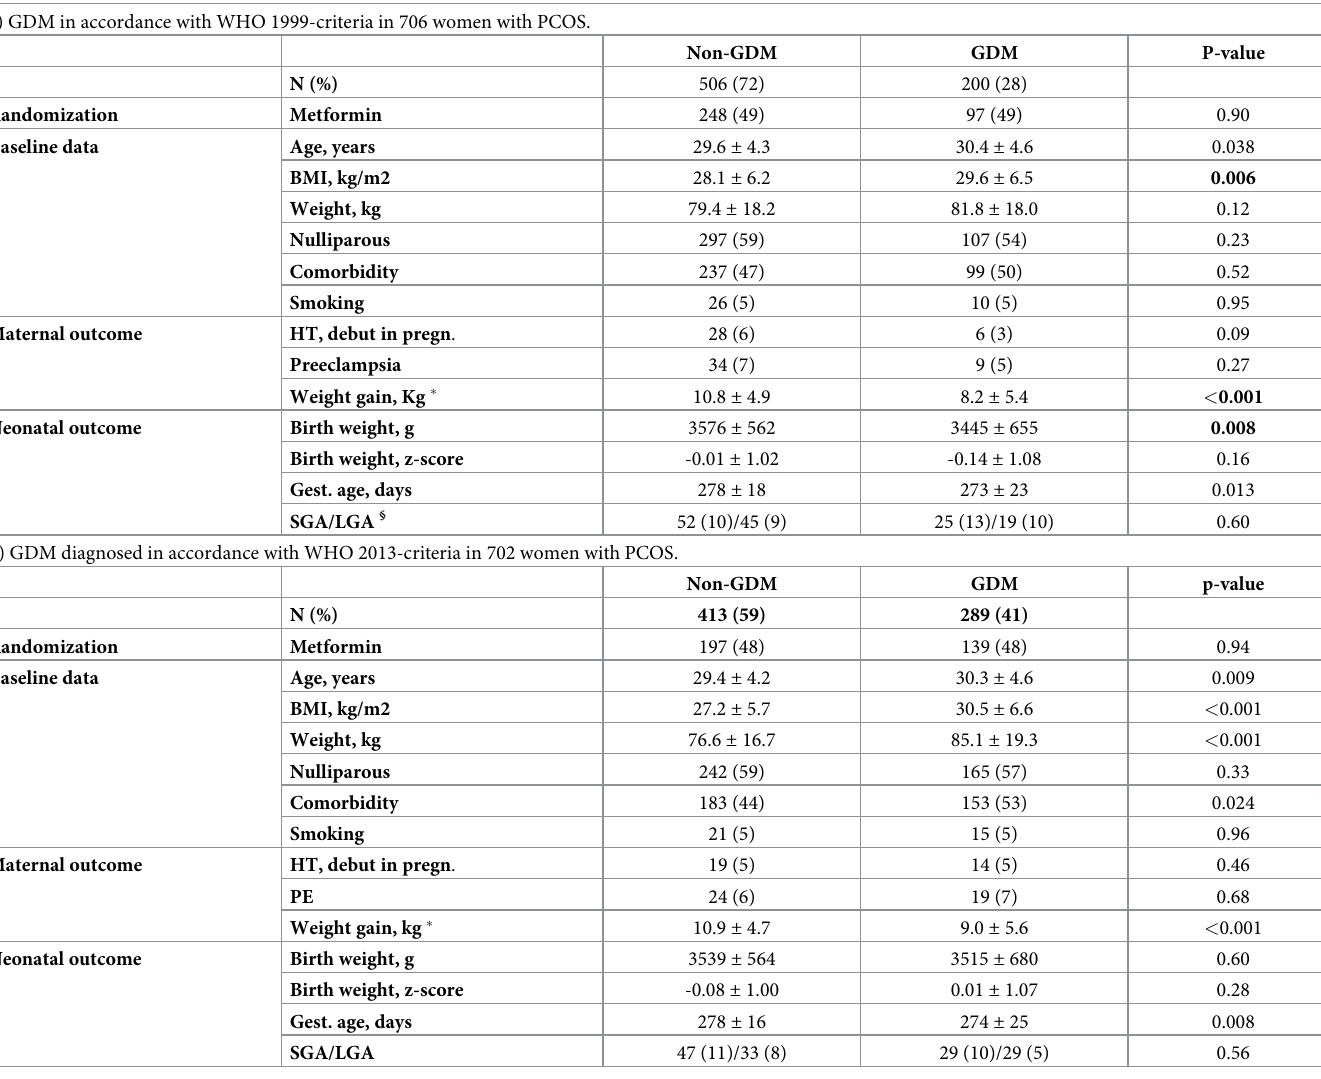
Table 1. Clinical characteristics and pregnancy outcome for women with and without gestational diabetes (GDM). a) GDM in accordance with WHO 1999-criteria in 706 women with PCOS. b) GDM diagnosed in accordance with WHO 2013-criteria in 702 women with PCOS. a) GDM in accordance with WHO 1999-criteria in 706 women with